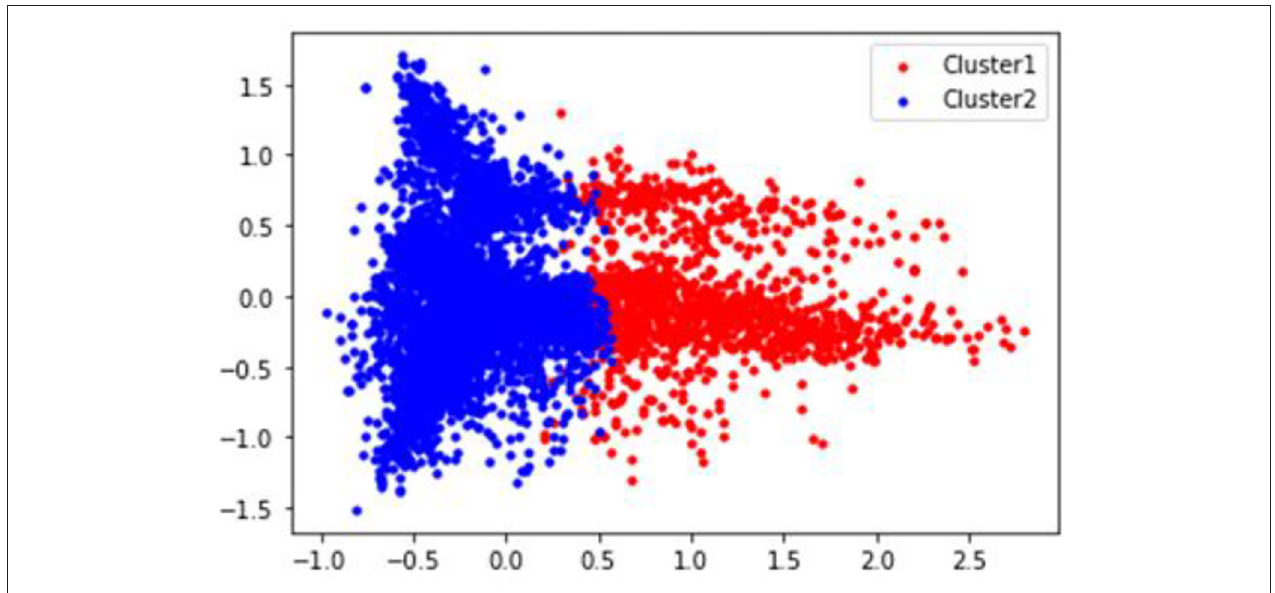
FIGURE 7 | The result of k-means